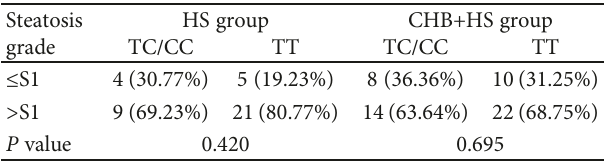
Table 4: Association tests of PNPLA3 rs1010023 with steatosis grade.